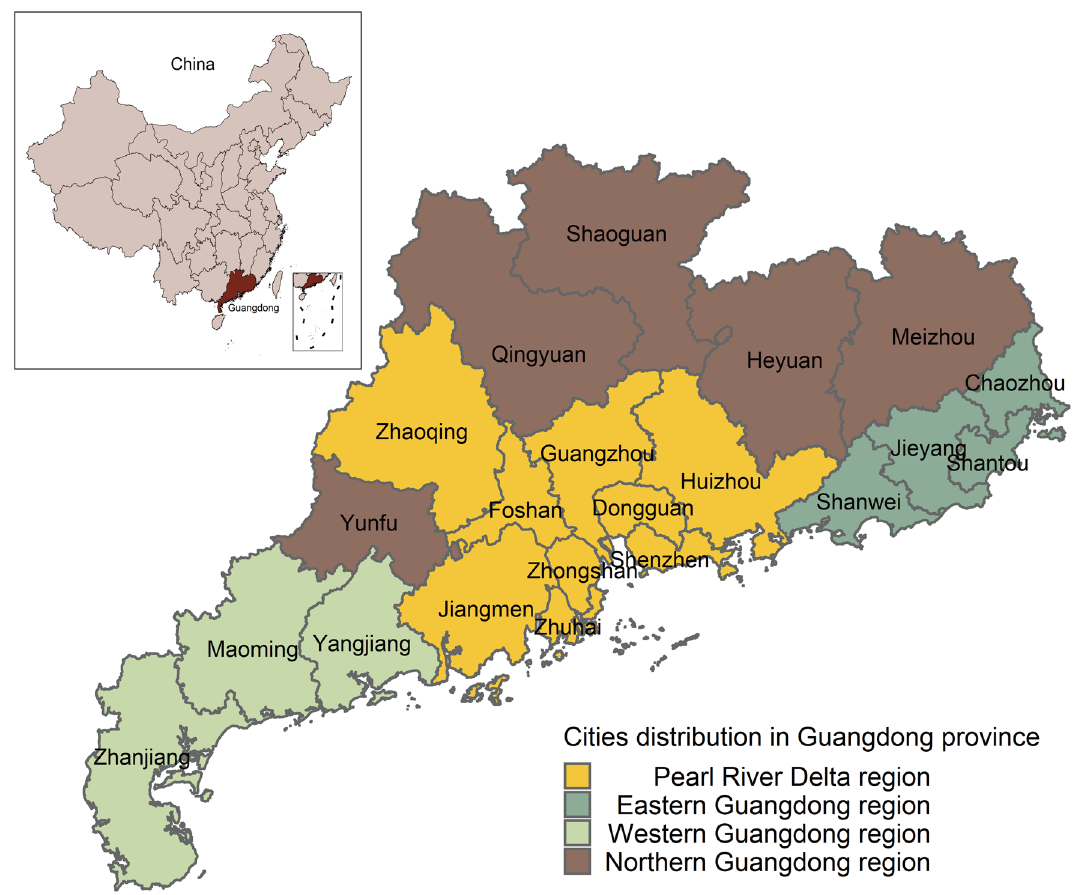
Figure 1. Geographical location of the study. Guangdong Province is located in southern China and is divided into four regions: the Pearl River Delta, Eastern, Western, and Northern Guangdong, which are marked in yellow, green, gray and brown,